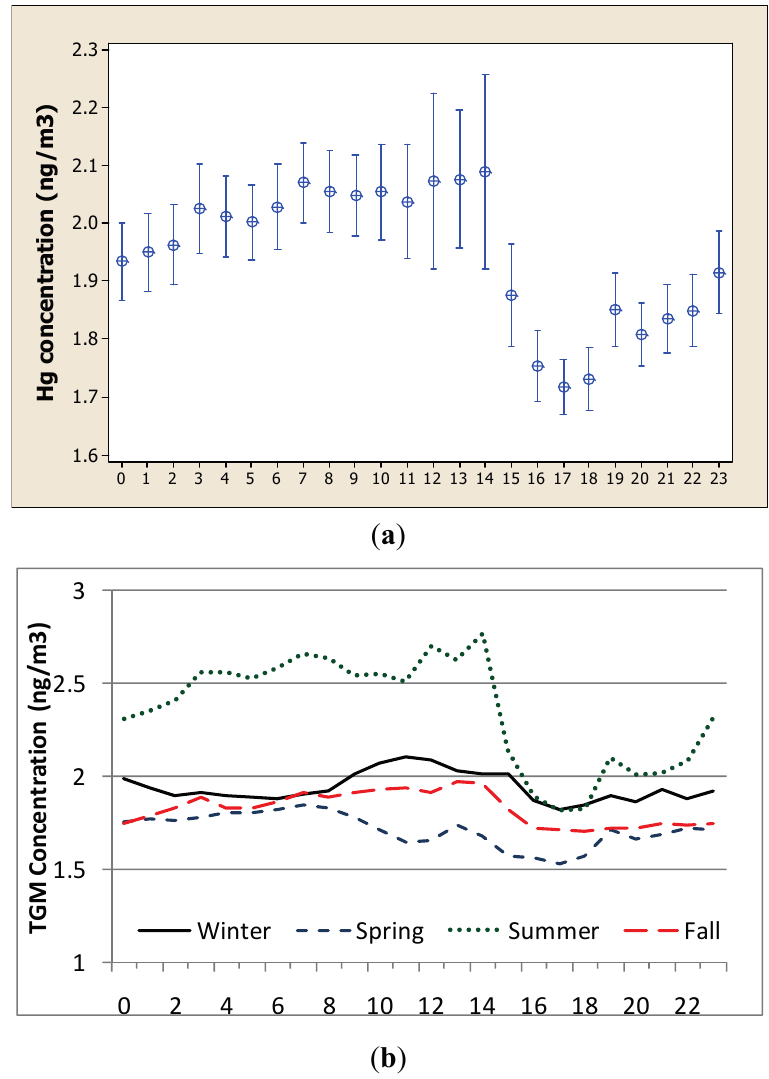
Figure 5. Hour-of-day TGM ( a ) during 2007–2011 (circles are means and bars represent 95% confidence intervals of means), and ( b ) by season.